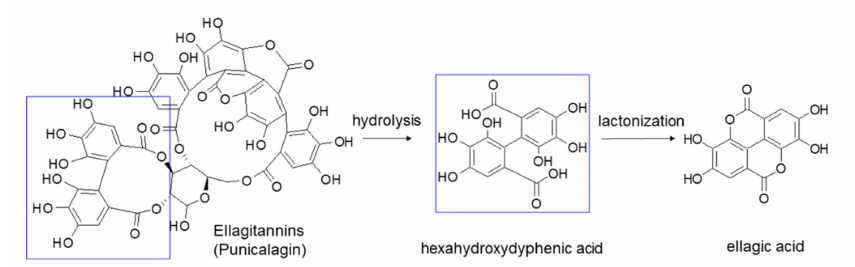
Figure 1. Hydrolysis of punicalagin (a pomegranate ellagitannin) to produce ellagic acid. Present also in a large variety of tropical fruit, nuts, berries (strawberries, raspberries, blackberries, cranberries, goji berries) and in a type of edible mushroom (Fistulina epatica), EA has